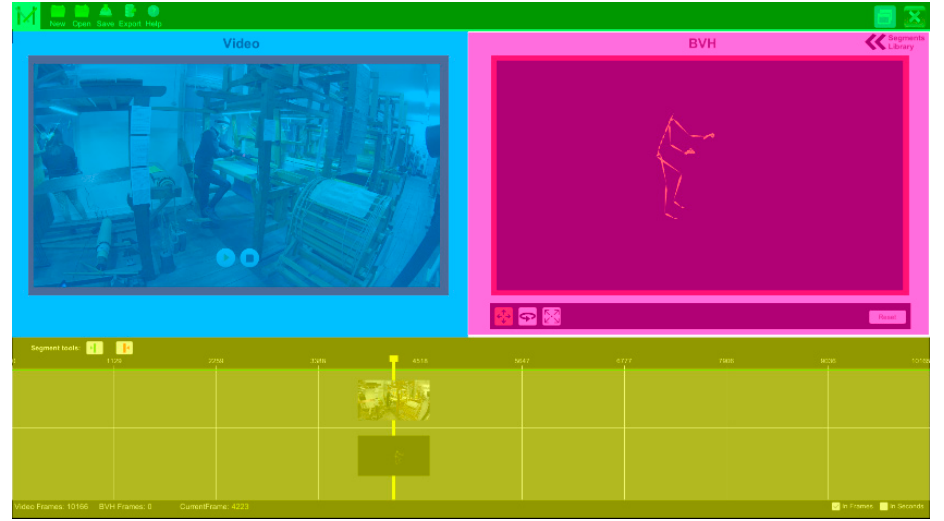
Figure 2. Editor window.